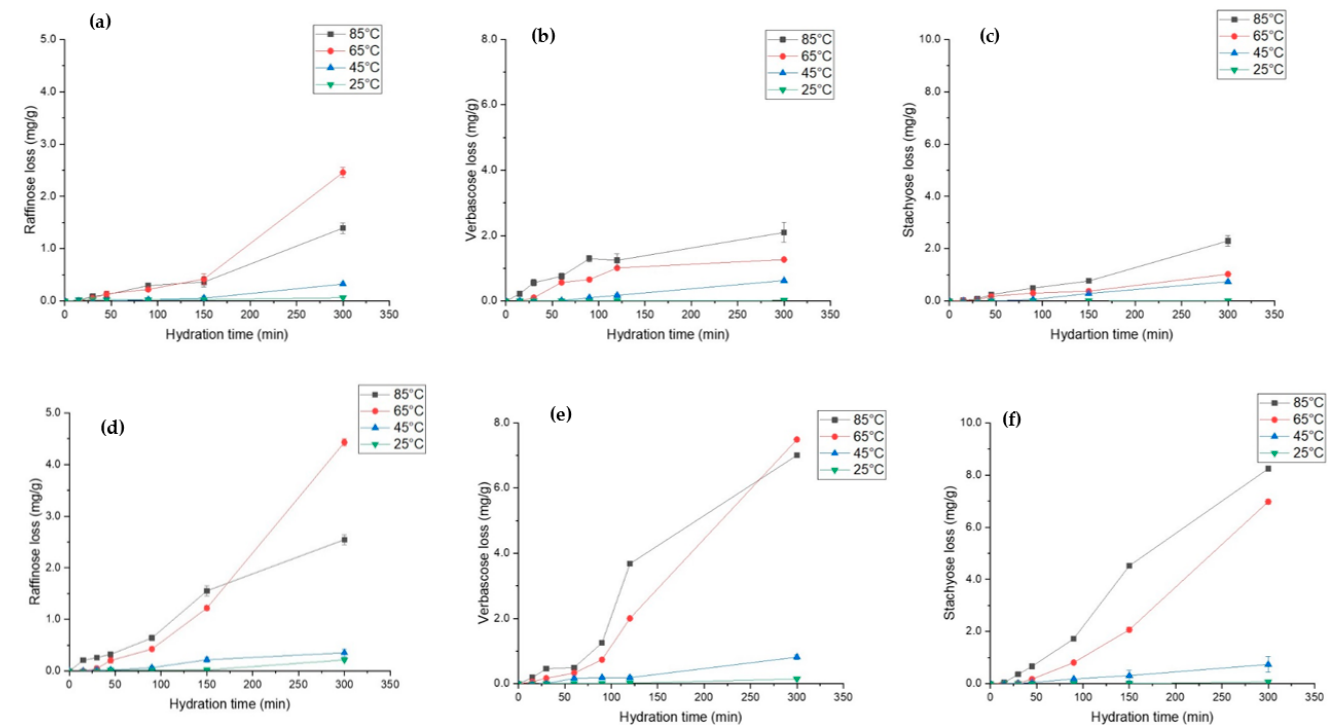
Figure 6. Soluble fibre loss during hydration of L. albus at four different temperatures, namely, ( a ) raffinose loss ( b ), verbascose loss, and ( c ) stachyose loss, and for L. angustifolius , ( d ) raffinose loss, ( e ) verbascose loss, and ( f ) stachyose loss.